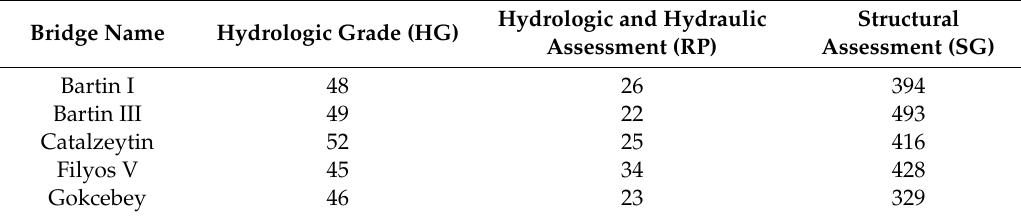
Table 15. Inspection grades for river bridges.